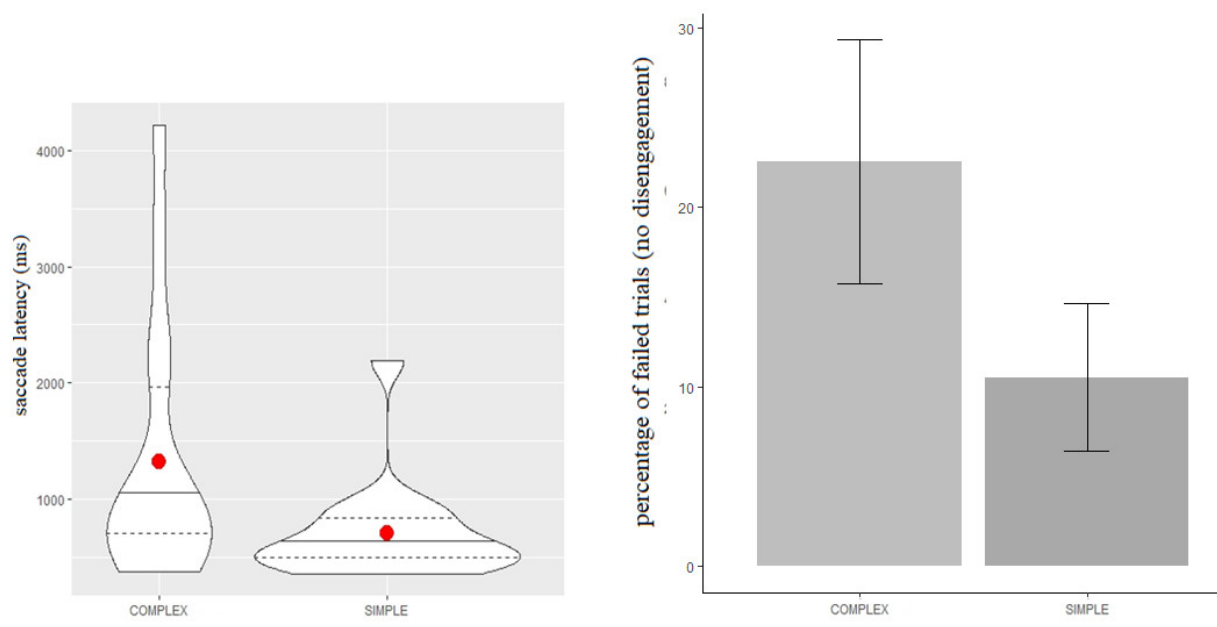
Figure 2. Violin plot of disengagement latency (left panel) and bar plot of percentage of failed trials and associated standard errors (right panel) for the complex and simple condition. Median (red dot), first and last quartile (dashed line) of data distribution are drawn.